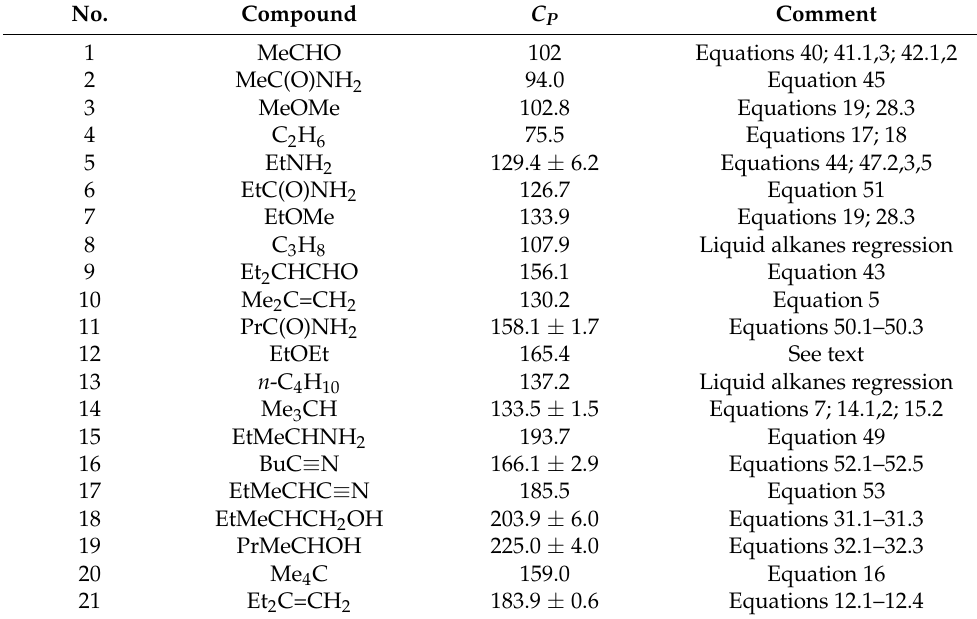
Table 5. Liquid-phase isobaric molar heat capacities C P , J/mol · K, 298 K estimated by the homod- esmotic method 1